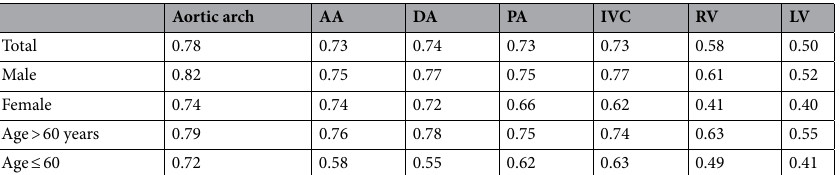
Table 3. Correlation coefficients of various CT attenuation values with serum Hb level. CT computed tomography, Hb hemoglobin, AA ascending aorta, DA descending aorta, IVC inferior vena cav.